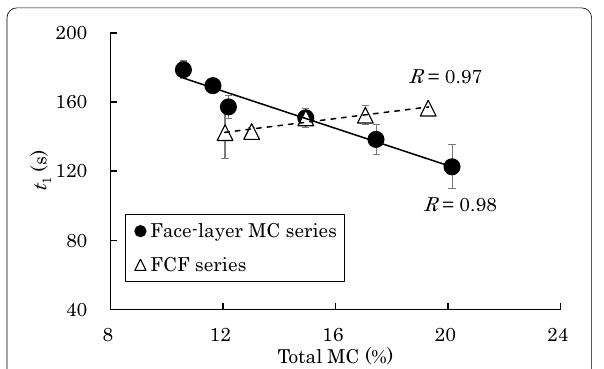
Fig. 6 Relationship between t 1 and total MC for the mats in the face-layer MC and FCF series: the solid and dashed lines are the regression lines of the face-layer MC and FCF series, respectively